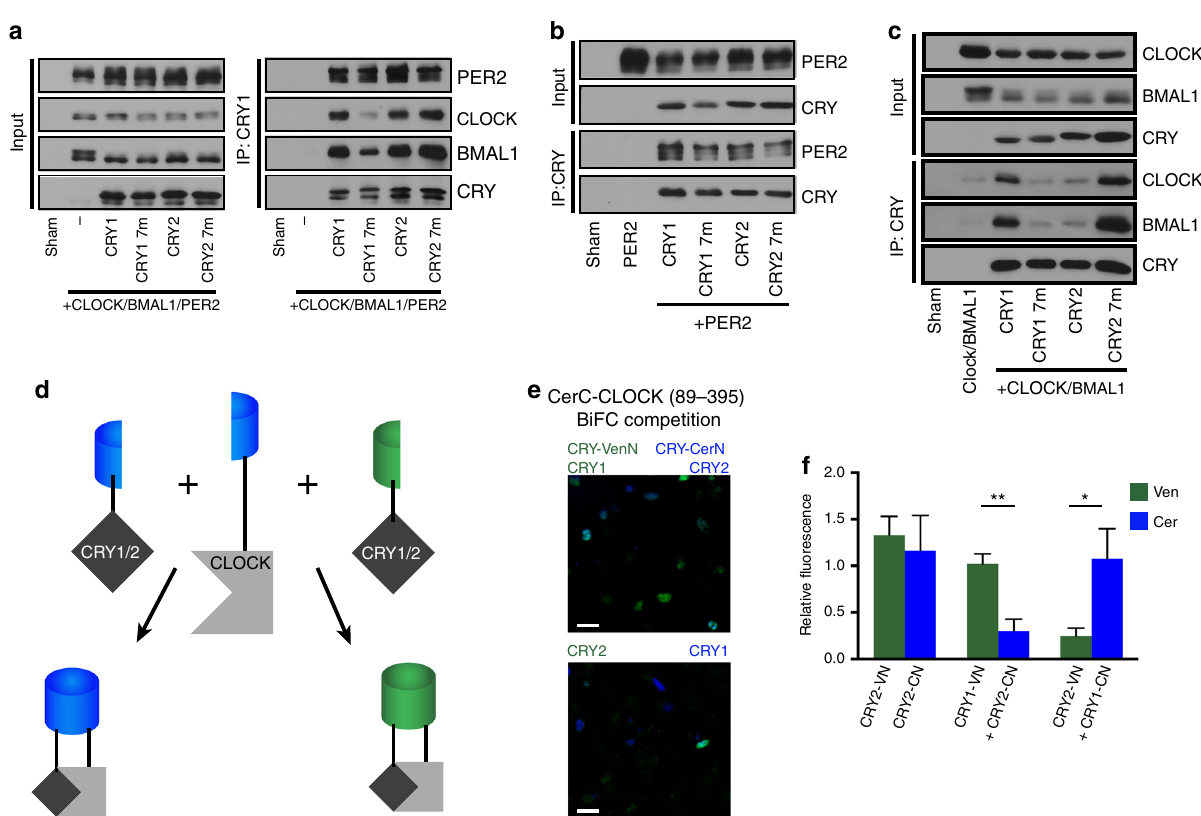
Fig. 7 CRY2 requires PER to form a stable complex with mCLOCK and mBMAL1. a Co-IP assay with mPER2, mCLOCK, mBMAL1, and CRY1, CRY2, or pocket-switched mutants. Multiple bands in mPER2, mCLOCK, and mBMAL1 lanes are indicative of post-translational modi fi cations on these proteins. The upper band is CRY, the lower band is a nonspeci fi c band recognized by the V5 antibody used to probe for mPER2. Blot is representative of three independent experiments. b Co-IP assay with mPER2 and CRY1, CRY2, or pocket-switched mutants. Blot is representative of three independent experiments. c Co-IP assay with mCLOCK and mBMAL1, and CRY1, CRY2, or pocket-switched mutants. Blot is representative of three independent experiments. d Schematic of bimolecular fl uorescence complementation competition assay. A CLOCK construct (residues 89 – 395) is N terminally tagged with a C-terminal fragment of Cerulean, which can interact with either an N-terminal fragment of Venus or Cerulean to produce yellow or blue fl uorescence. CRY1 or CRY2 fused to these N-terminal fragments compete to bind CerC-CLOCK and fl uorescence is used as a readout in the competition for binding. e Reciprocal two-color, three-way bimolecular fl uorescence complementation (BiFC) in 293A cells using CerC-CLOCK (89 – 395) complementation with CRY1-VenN + CRY2-CerN or CRY1-CerN + CRY2-VenN. Pseudocoloring: Venus (Green), Cerulean (Blue). Scale bar is 30 μ m. f Quanti fi cation of BiFC results. Bar graphs show the mean ± SEM of six biological replicates from two independent experiments. Asterisks show signi fi cance by unpaired t test with Welch ’ s correction (* p = 0.0494, ** p =